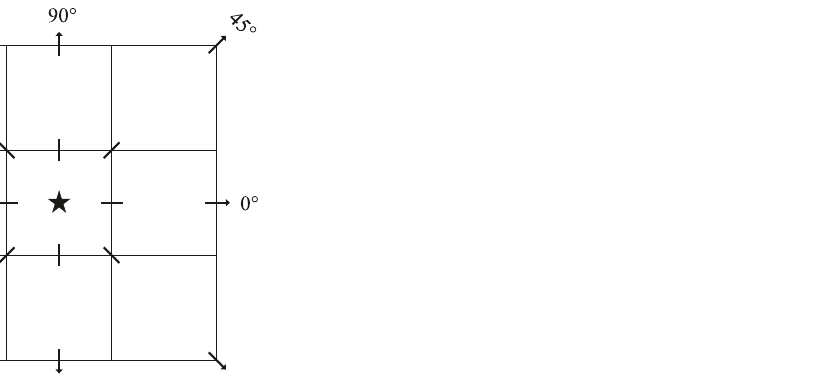
Figure 2. Classical spatial relationship to compute a GLCM for Haralick textural features using a 3 × 3 window. A relationship is defined through a single displacement using a distance d along one of the shown axes orientations, i.e., θ = { 0 ◦ ,45 ◦ ,90 ◦ ,135 ◦ } , for the horizontal, right diagonal, vertical, and left diagonal neighbors.